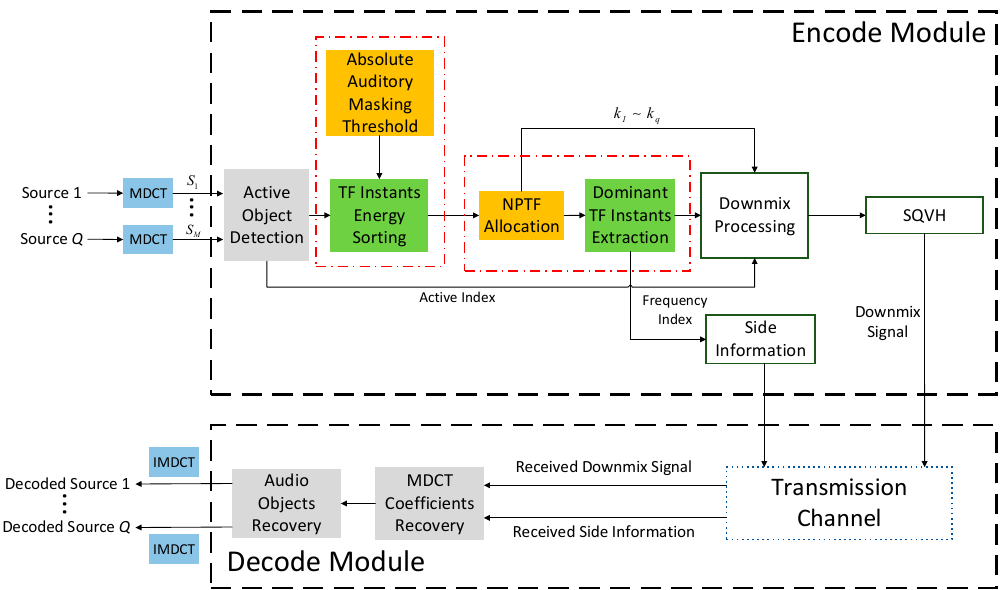
... Decoded Source Q